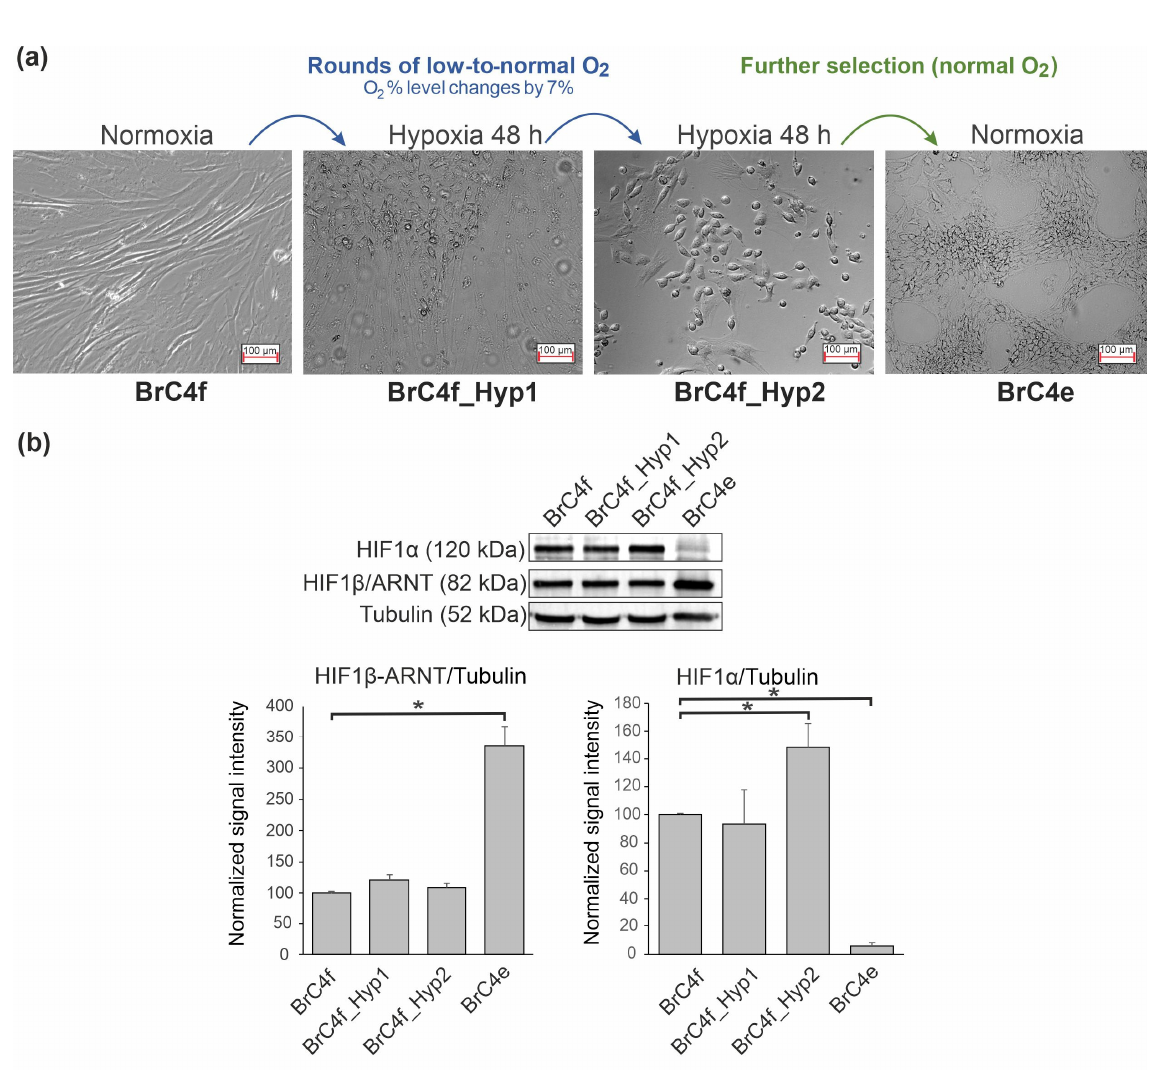
Figure 1. ( a ) Inline transformation of BrC4f cells under rounds of pulsed hypoxia. Cell morphology was monitored by phase-contrast microscopy. ( b ) Western blots analysis of HIF-1 β /ARNT and HIF-1 α in cells. Beta-tubulin was used as a loading control. The differences were significant with * p < 0.05 between two groups.